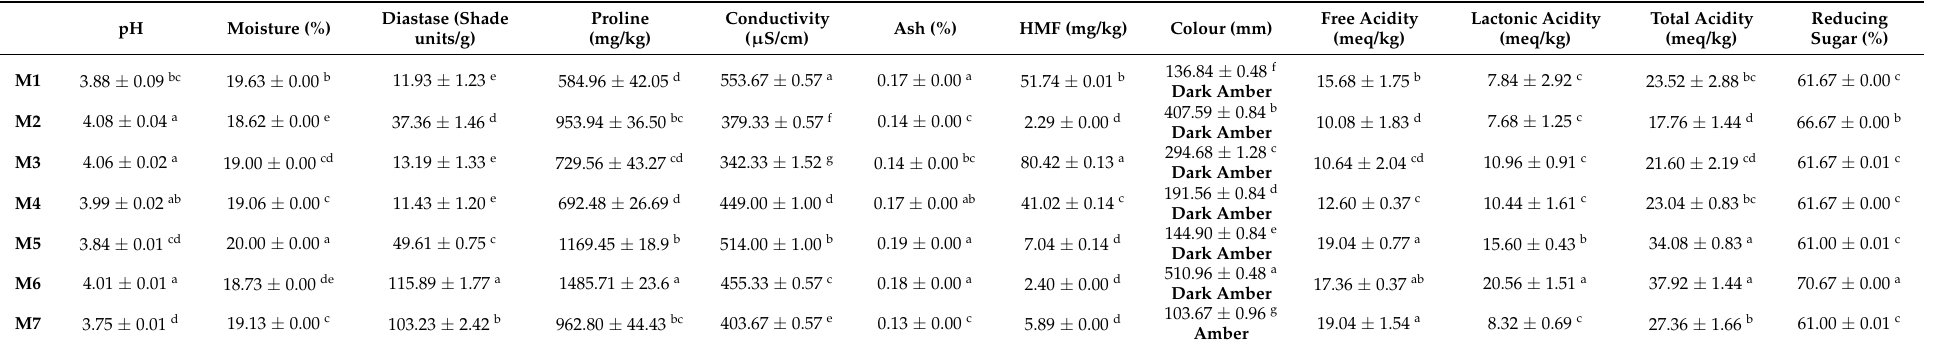
The values in the same column followed by the same letter are not significantly different ( p < 0.05) by Tukey’s multiple range